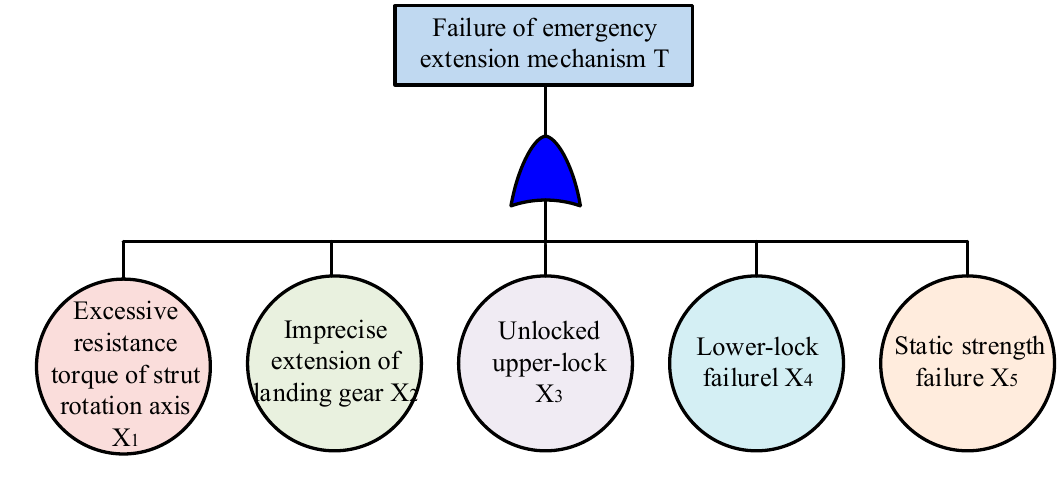
Figure 2. Fault tree of emergency extension.